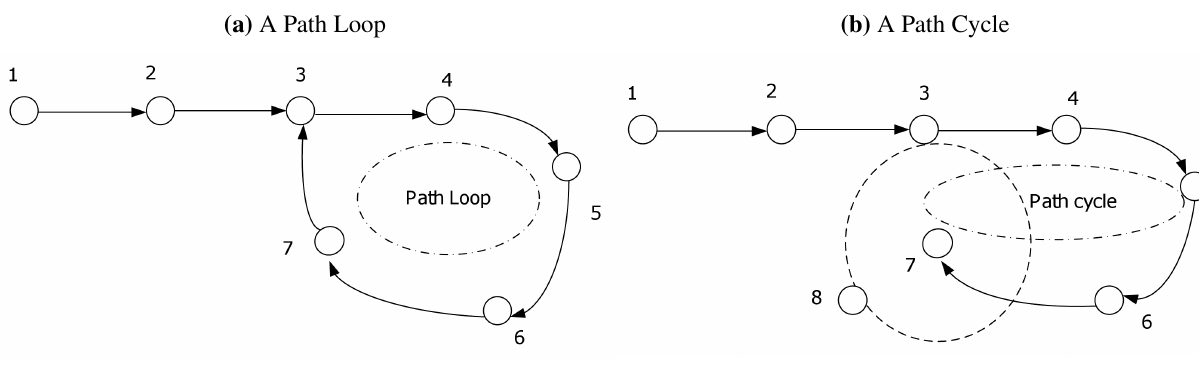
Figure 4. Examples of Path loop and Path